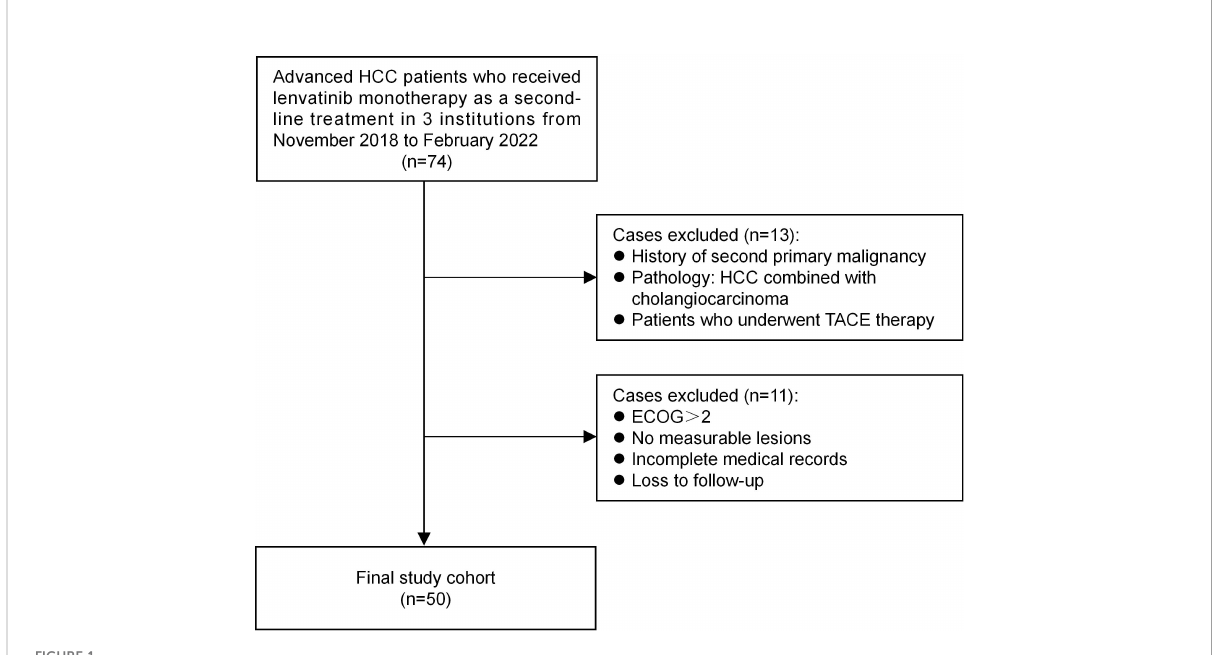
FIGURE 1 Study fl ow chart: Flow diagram of patient selection